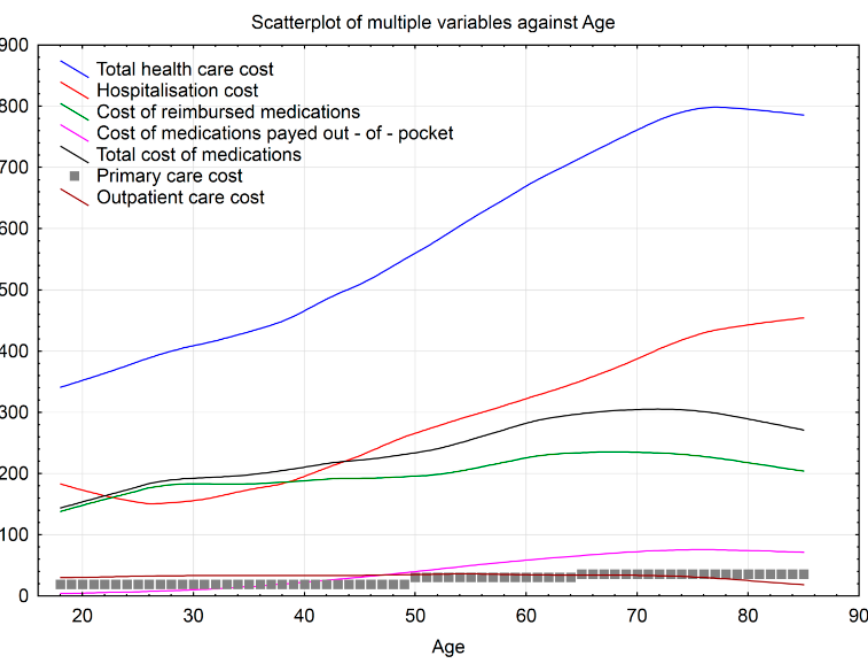
Figure 1. Trends of the mean annual cost of a patient with multimorbidity in different age groups. Hospitalization costs amounted to the highest cost for age from 18 to 22 years and 40 years on (with the minimum cost reached in the age of around 25 years), then increased steadily until the age of around 79 years and stabilised again. The average cost of medica- tions increased in a similar steady fashion until the age of around 72 years and stabilised afterwards. The cost of medication paid out-of-pocket increased more markedly than the reimbursed cost between the age of 28 and 53 years. Importantly, although the price of medications and hospitalization was comparable for age groups up to around 50 years,